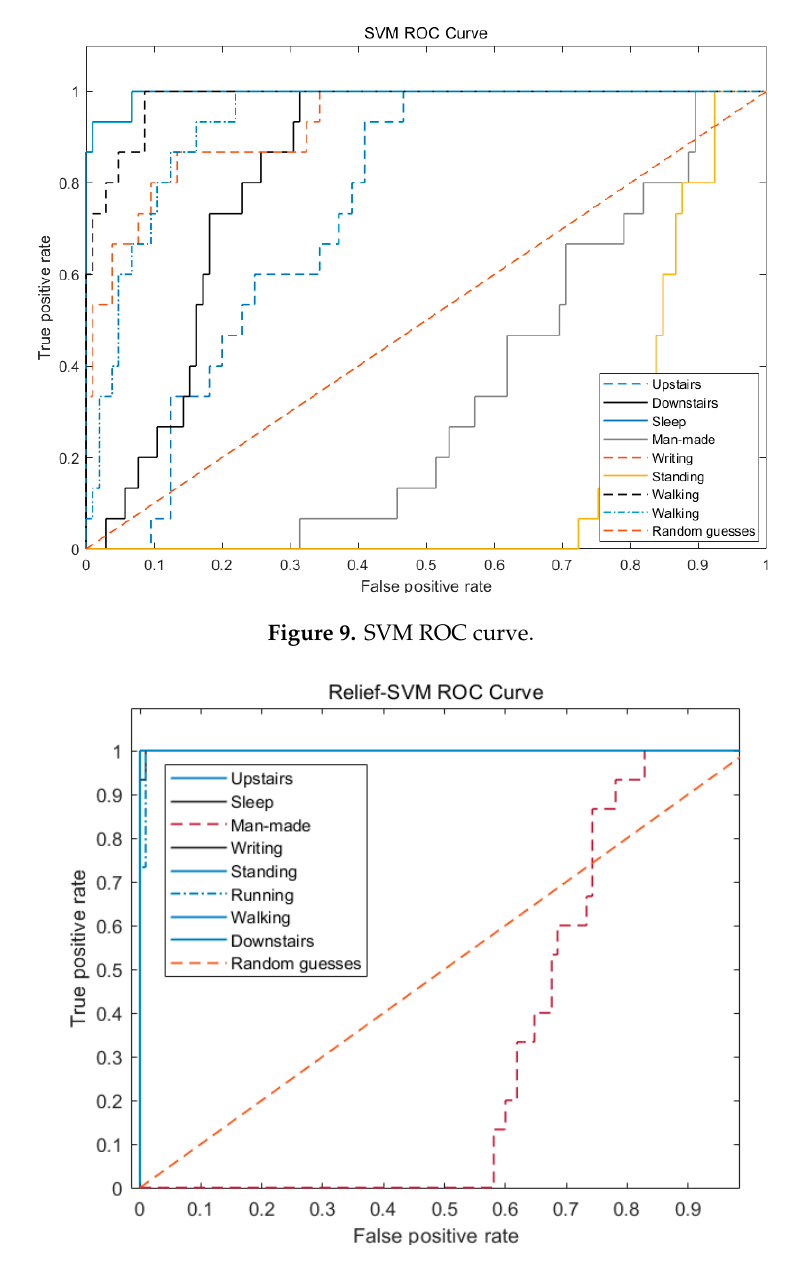
Figure 10. Relief ‐ SVM ROC curve.